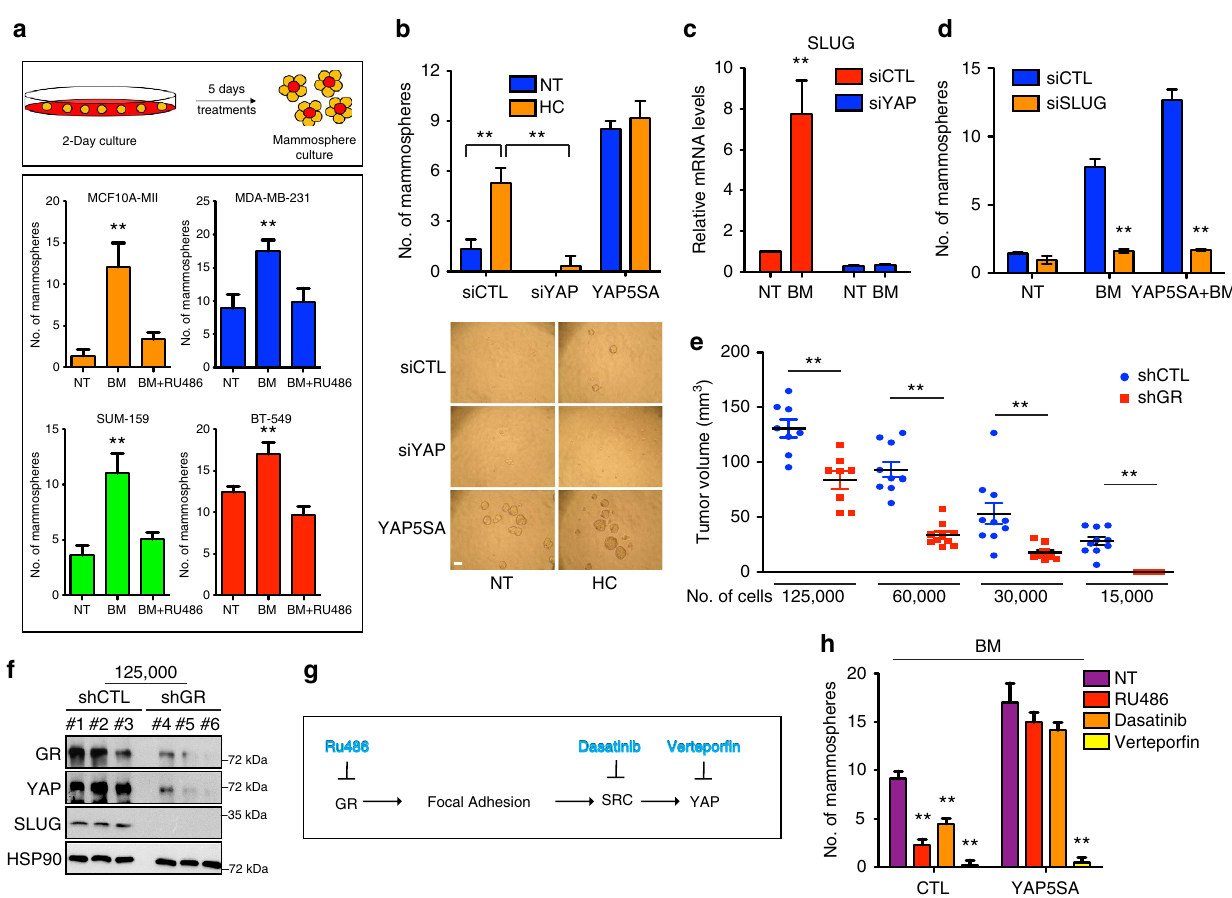
Figure 6 | YAP is required for glucocorticoids-induced stem cells traits in breast cancer cells. ( a ) Upper panel: schematic representation of the experiment. Cells were grown in 2-day culture and treated with indicated compounds for 5 days, then cells were cultured in mammosphere conditions. Lower panel: number of secondary mammospheres generated from the indicated breast cancer cell lines treated with vehicle (NT) or betamethasone 1 m M (BM) alone or in combination with RU486 1 m M. Error bars represent mean ± s.d., from n ¼ 3 biological replicates. ( b ) Upper panel: number of secondary mammospheres generated from MII cells overexpressing control vector (CTL) or YAP5SA, transfected with control (siCTL) or YAP (siYAP) siRNA and treated as indicated. HC is hydrocortisone 1 m M. Lower panel: representative images of mammospheres. Error bars represent mean ± s.d., from n ¼ 3 biological replicates. siYAP sequence is siYAP#1. ( c ) Quantitative PCR with reverse transcription analysis of MDA-MB-231 transfected with indicated siRNA for 48h and treated with 1 m M BM alone or in combination with RU486 1 m M for 24h. siCTL is control siRNA. Error bars represent mean ± s.d., from n ¼ 3 biological replicates. siYAP sequence is siYAP#1. ( d ) Number of secondary mammospheres generated from MII cells overexpressing control vector (CTL) or YAP5SA, transfected with indicated siRNA and treated as in a . Error bars represent mean ± s.d., from n ¼ 3 biological replicates. ( e ) Tumour volumes 21 days after injection of indicated number of MDA-MB-231-shCTL or MDA-MB-231-shGR cell into mammary fat pad of mice. Error bars represent mean ± s.e.m. ( f ) Lysates of tumours from 125,000 MDA-MB-231-shCTL or MDA-MB-231-shGR cells injected in mice were immunoblotted with the indicated antibodies. The numbers are mice identificative numbers. ( g ) Schematic representation summarizing drugs and their targets. ( h ) Number of secondary mammospheres from MII cells overexpressing control vector (CTL) or YAP5SA. Cells were treated as in a with indicated compounds. Error bars represent mean ± s.d., from n ¼ 3 biological replicates. * P o 0.05, ** P o 0.01; two-tailed Student’s t -test is used